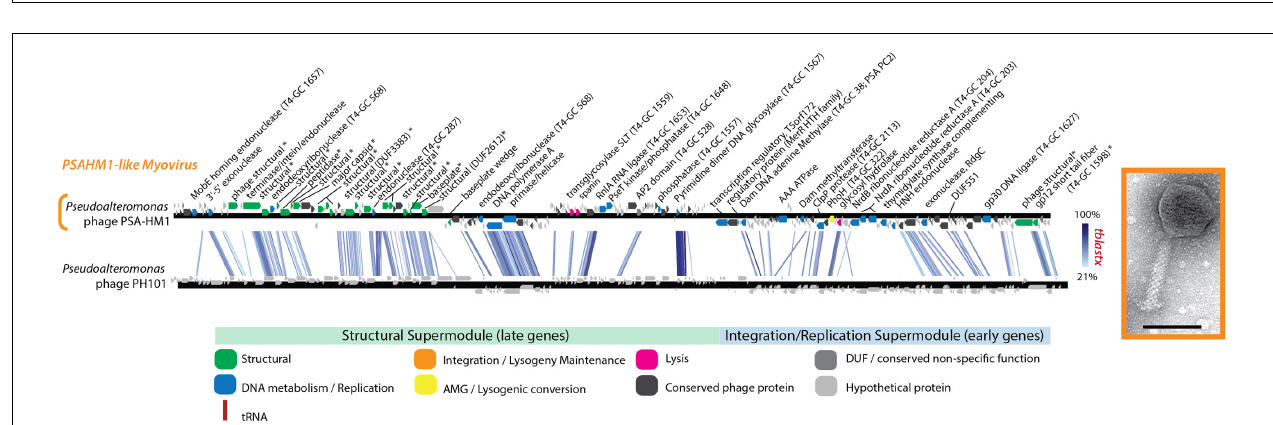
FIGURE 5 | (A) Full-genome comparison based on BLASTN similarity between PSA-HS6 and three integrated prophages identified in sequenced Pseudoalteromonas host genomes in the Whole Genome Shotgun (WGS) dataset: Pseudoalteromonas sp. BSi20652 contigs 20 (BADT01000020) and 220 (BADT01000220); Pseudoalteromonas haloplanktis TAE80 contigs 141 (AUTM01000141), 321 (AUTM01000321), 174 (AUTM01000174), and 152 (AUTM01000152); Pseudoalteromonas haloplanktis ANT/505 contig 27 (NZ_ADOP01000027). ∗ Denotes proteins confirmed as structural by mass spectroscopy-based proteomics. (B) Full-genome comparison based on TBLASTX similarity between PSA-HS6, Enterobacteria phage Mu, Pseudomonas phage D3112, and Shewanella phage 1/44. This representation shows the conserved elements in the head and integration/replication modules shared between PSA-HS6 and Enterobacteria phage Mu, as well as Pseudomonas phage D3112—representing a group of phage where this Mu head and siphovirus tail has been previously described (Wang et al., 2003; Cazares et al., 2014). Further, this representation depicts the siphovirus-like tail shared between PSA-HS6 and Shewanella phage 1/44.